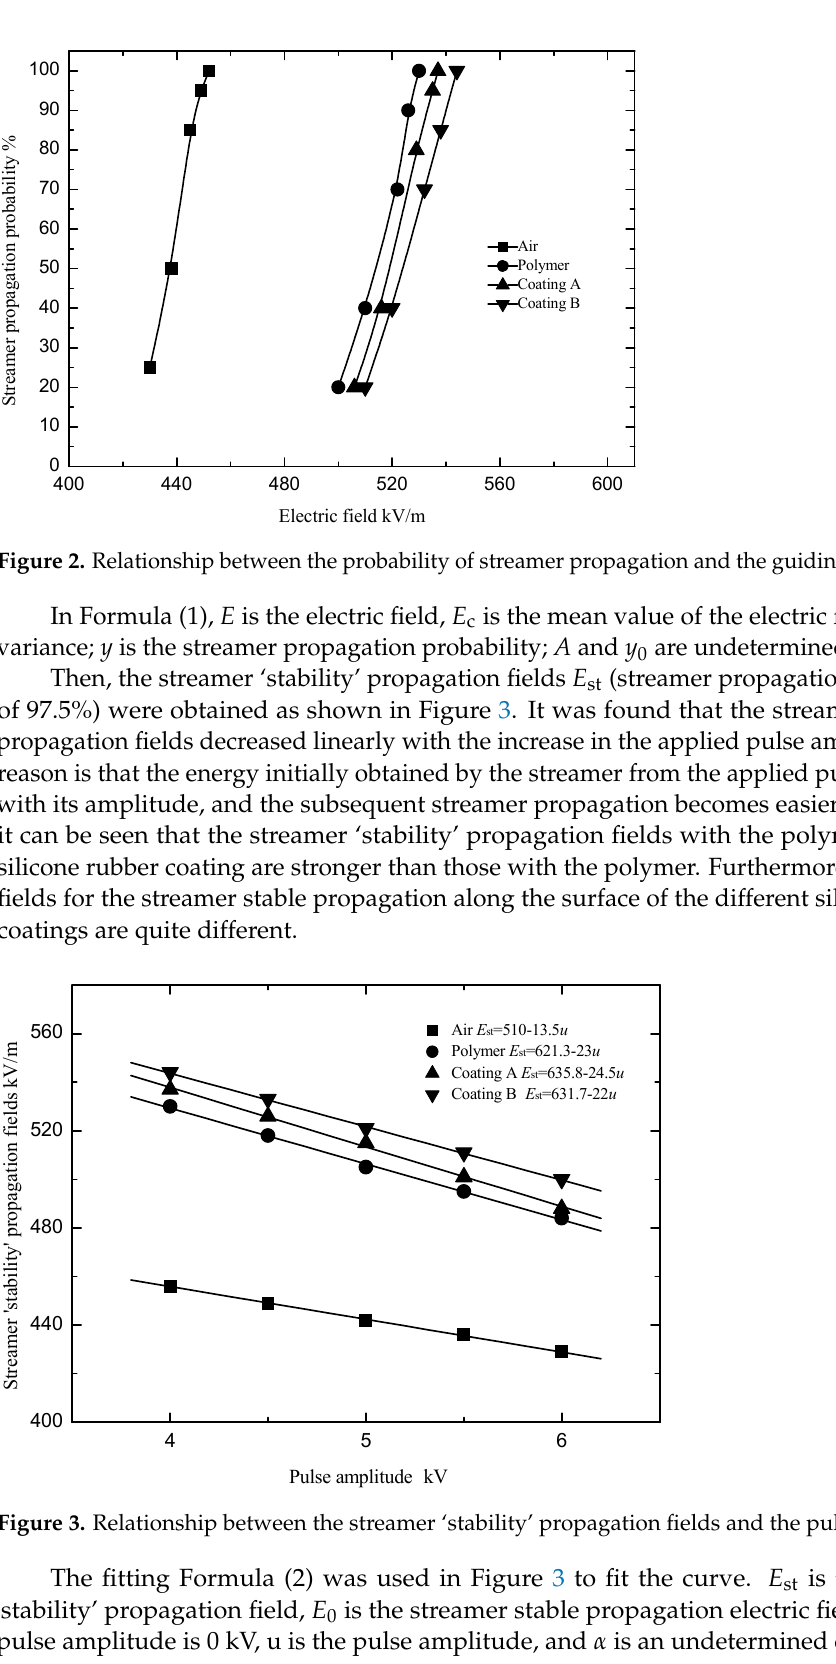
Figure 3. Relationship between the streamer ‘stability’ propagation fields and the pulse amplitude. The fitting Formula (2) was used in Figure 3 to fit the curve. E st is the streamer ‘stability’ propagation field, E 0 is the streamer stable propagation electric field when the pulse amplitude is 0 kV, u is the pulse amplitude, and α is an undetermined